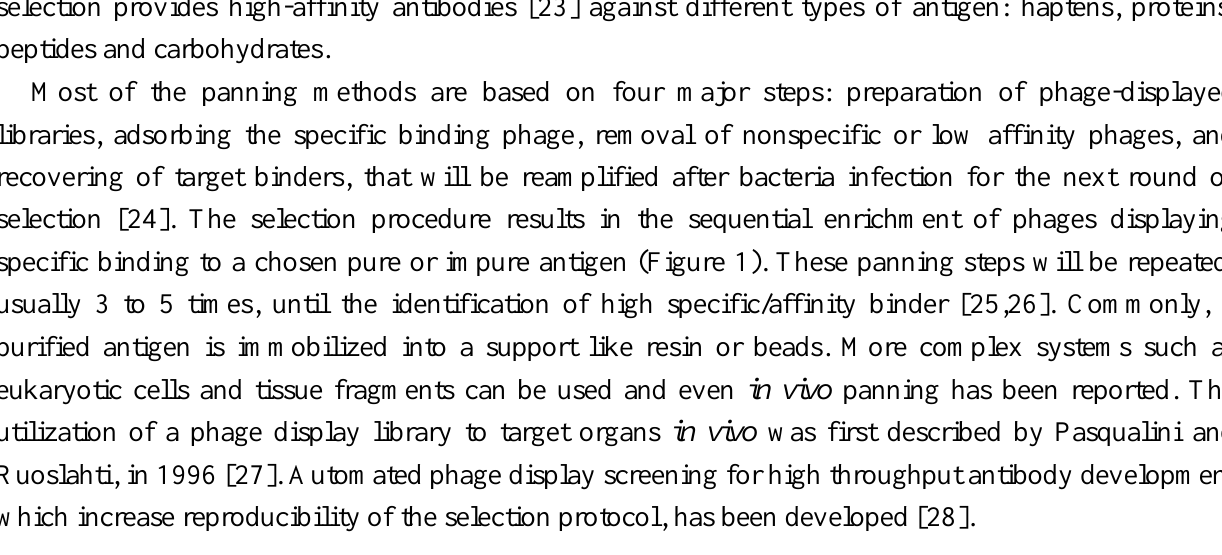
Figure 1. General scheme of phage display technology. ( A ) Generation of a phage display library by mRNA extraction, cDNA cloning into a phagemid vector and phage propagation; ( B ) Biopanning: affinity against tumoral cells driven enrichment of target specific